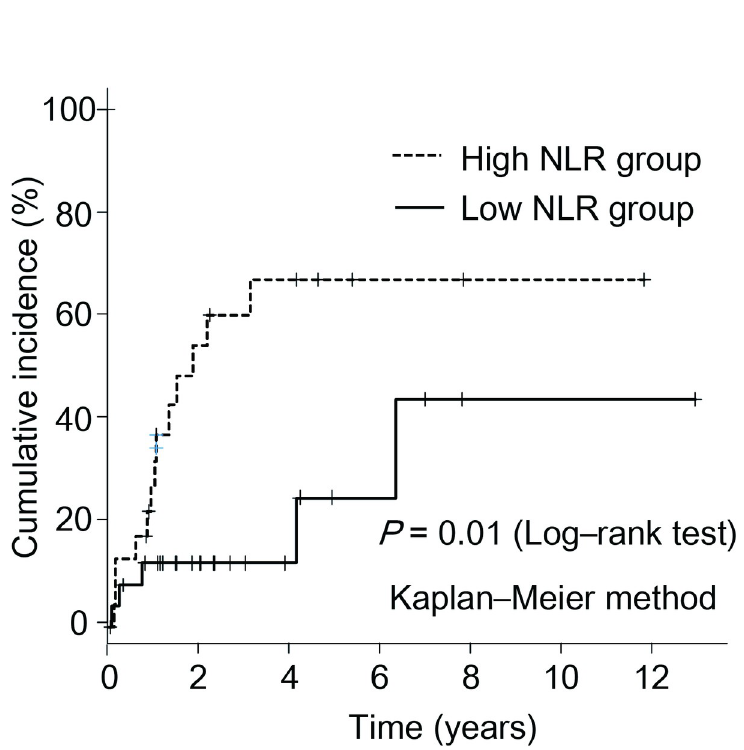
Fig 3. Comparison of cumulative incidence of pouchitis between the high and low NLR groups. The incidence of pouchitis was significantly lower in the low NLR group than in the high NLR group (P = 0.01, log-rank test).